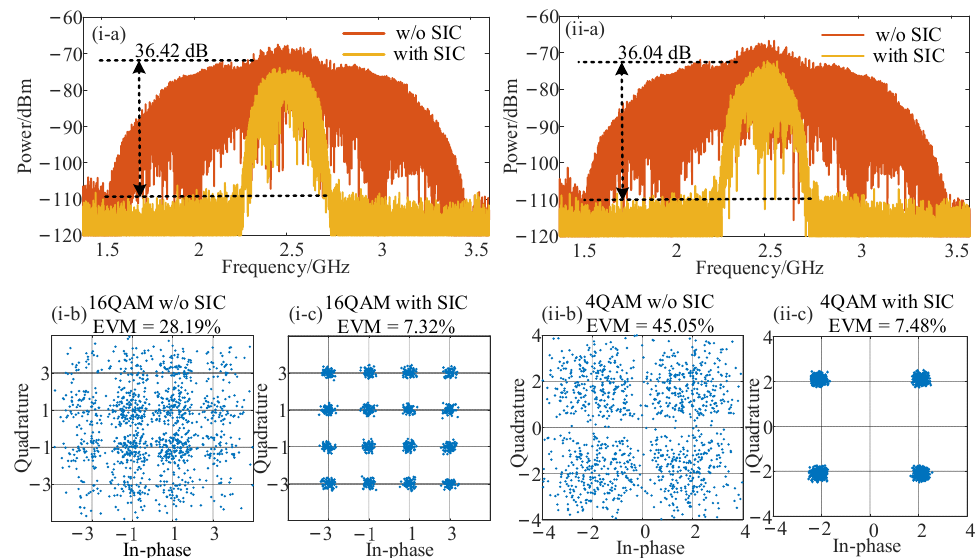
Figure 4. The SOI recovery performance for fundamental down-conversion when a 2 GHz SI signal and a 500 MHz SOI centered at 12.5 GHz with the modulation formats of ( i ) 16-QAM and ( ii ) 4-QAM were used. ( a ) The measured electrical spectra with and without SIC, the measured EVM ( b ) without and ( c ) with SIC.